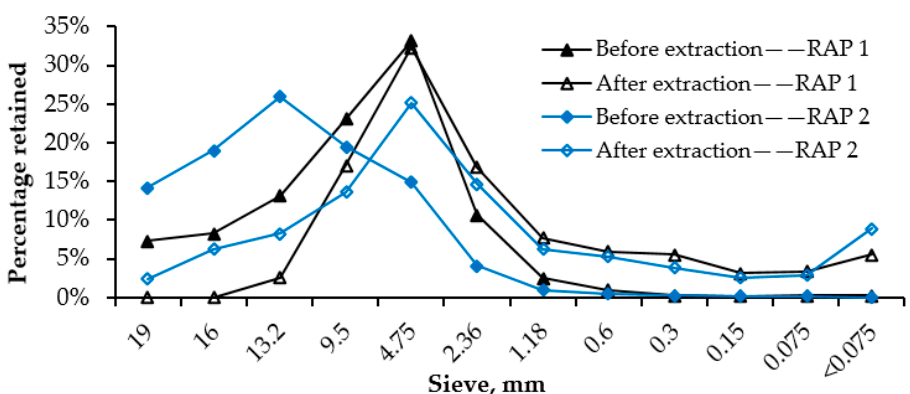
Figure 1. Percentage retained of reclaimed asphalt pavement (RAP) 1 and RAP 2 before and after extraction.